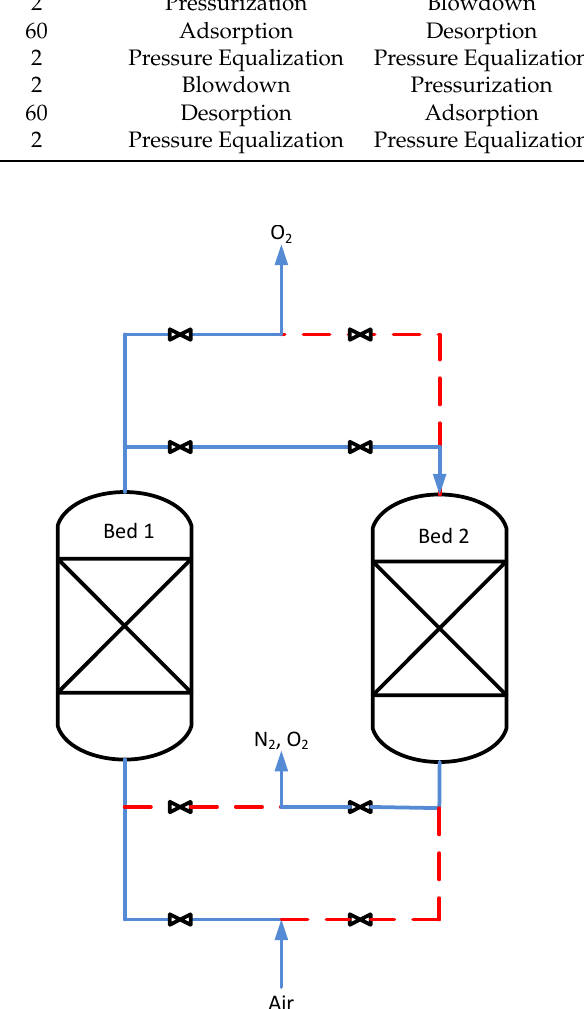
Figure 10. Schematic of the PSA system; the solid lines denote the flow pathway of the gas, while the dashed lines represent inactive piping in the cycle. As shown in the figure, Bed 1 is the active bed (flow denoted in blue), while Bed 2 is being regenerated.